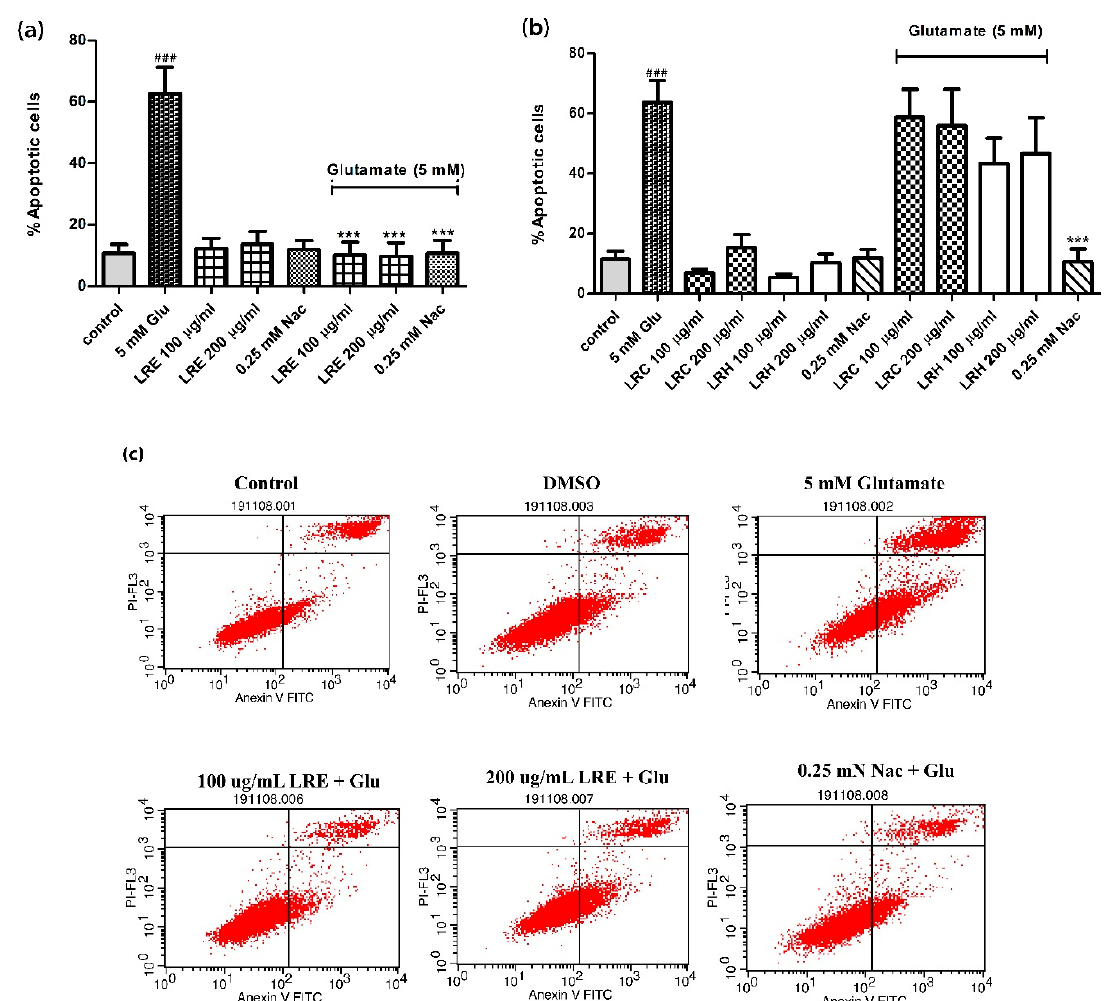
Figure 2. Quantitative flow cytometric analysis of the abundance of apoptotic HT22 cells using Annexin V-FITC/PI staining. Annexin V+/PI– cells are seen in the lower right are in the early stage and annexin V+/PI+ in the upper right quadrant are late stage. ( a ) Treatment of cells with glutamate, NAC and LRE alone or in combination with 5 mM glutamate; ( b ) Treatment of cells with glutamate, NAC and LRC and LRH alone or in combination with 5 mM glutamate; ( c ) Representative scatter plots of the distribution of annexin V and PI-stained cells. Values are mean ± SEM of at least three independent runs. ### p < 0.001 vs. control; *** p < 0.001 vs. glutamate alone.